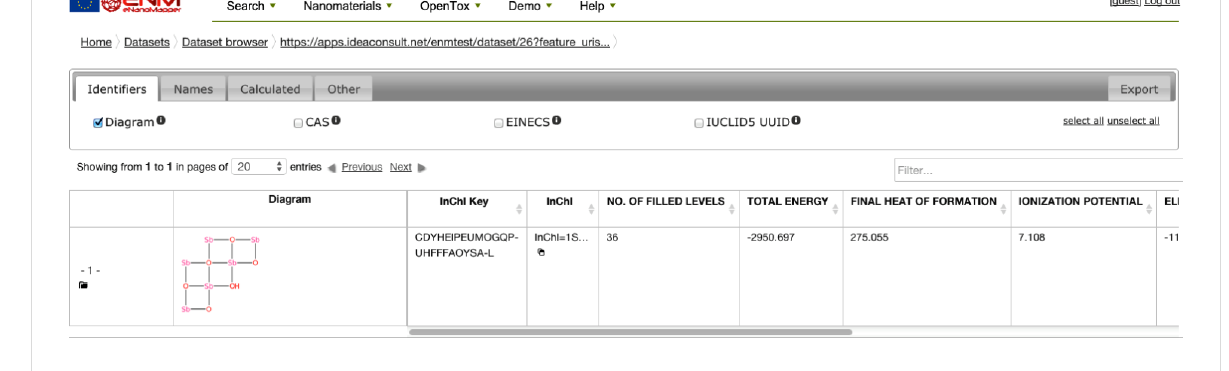
Figure 27: Screenshot of the descriptors calculated with quantum mechanics MOPAC web